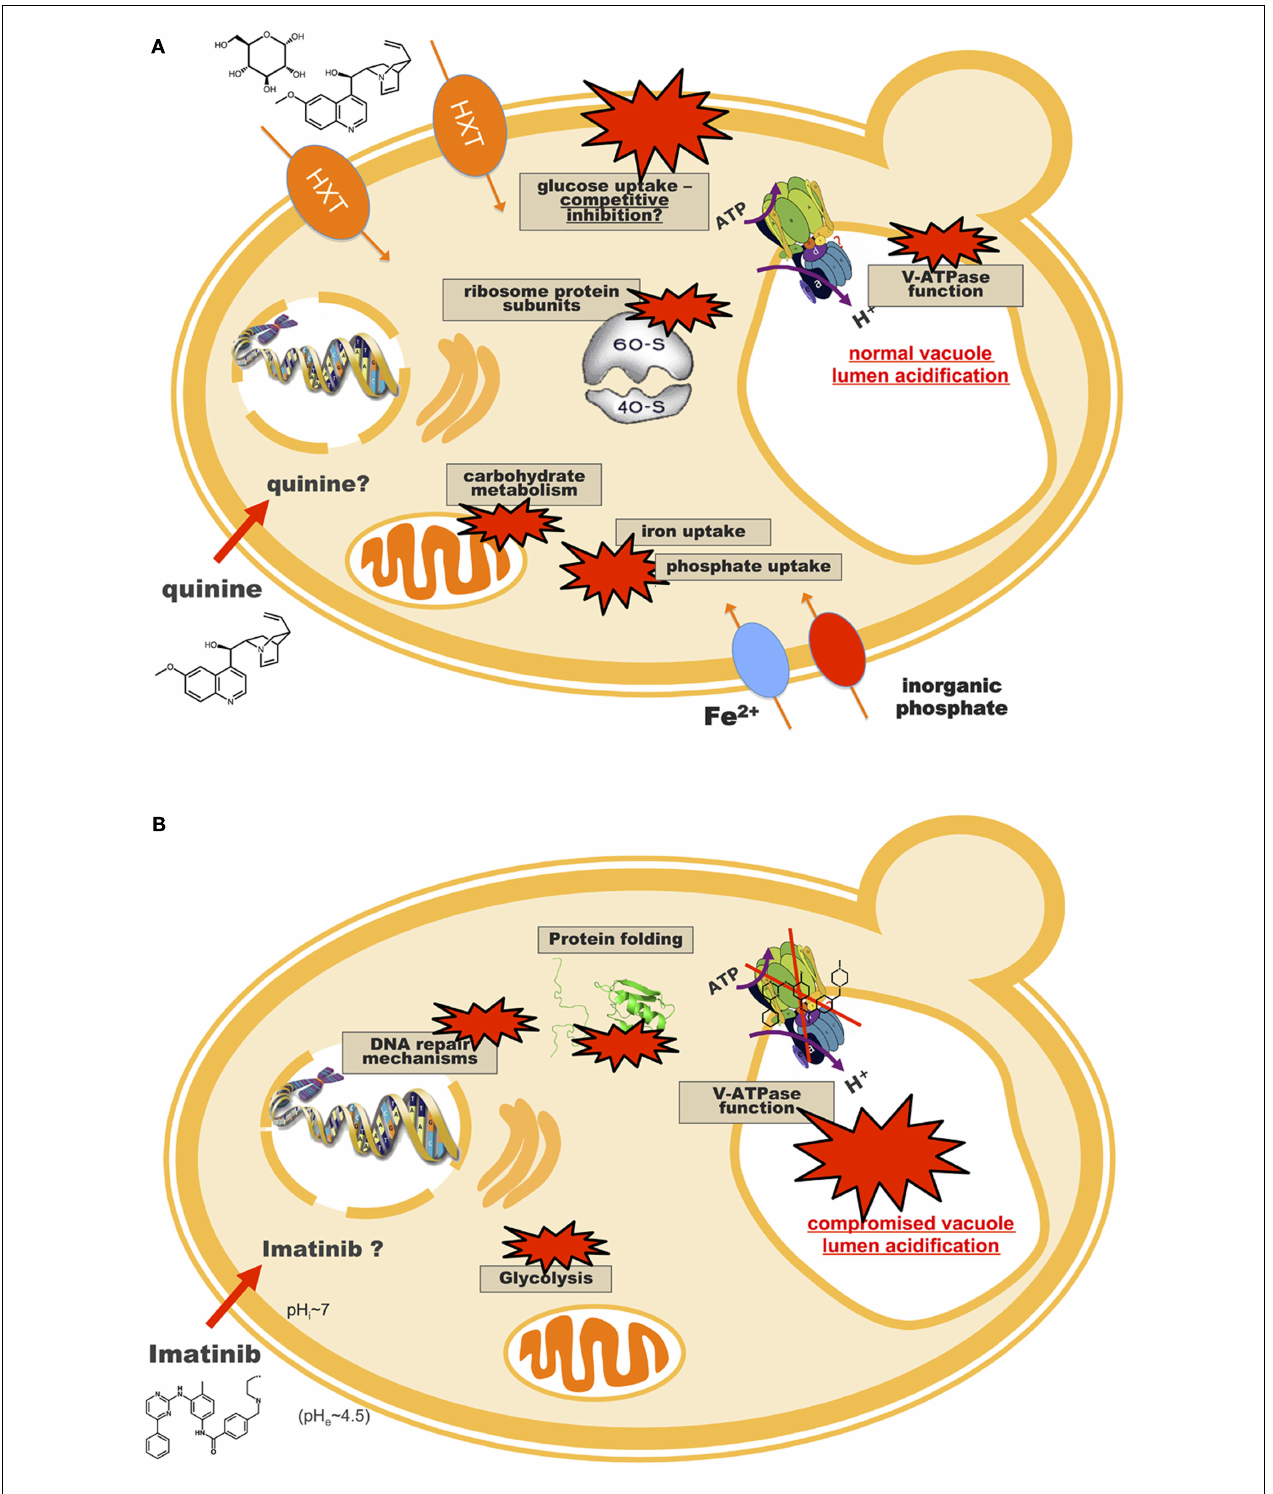
functional conservation in the organisms of interest, Plasmodium falciparum , and human cells, respectively.The most important results are the identification of PfHT1 as a potential target of quinine, as well as the vacuolar H + -ATPase (V-ATPase) as a target of imatinib (see Genome-wide Responses and Determinants of Resistance to Antimalarial Drugs and Genome-wide Responses and Determinants of Resistance to Anticancer